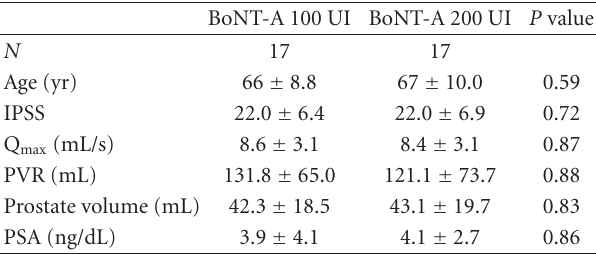
Table 1: Baseline characteristics of patients treated with intrapro- static